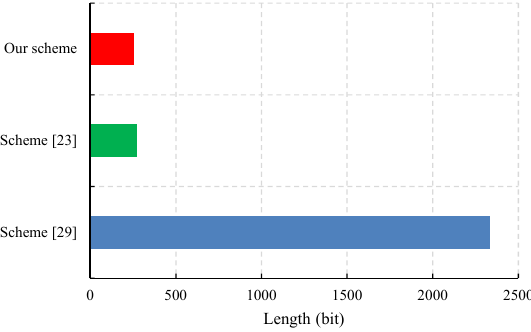
Figure 3. A comparison of the private key size.